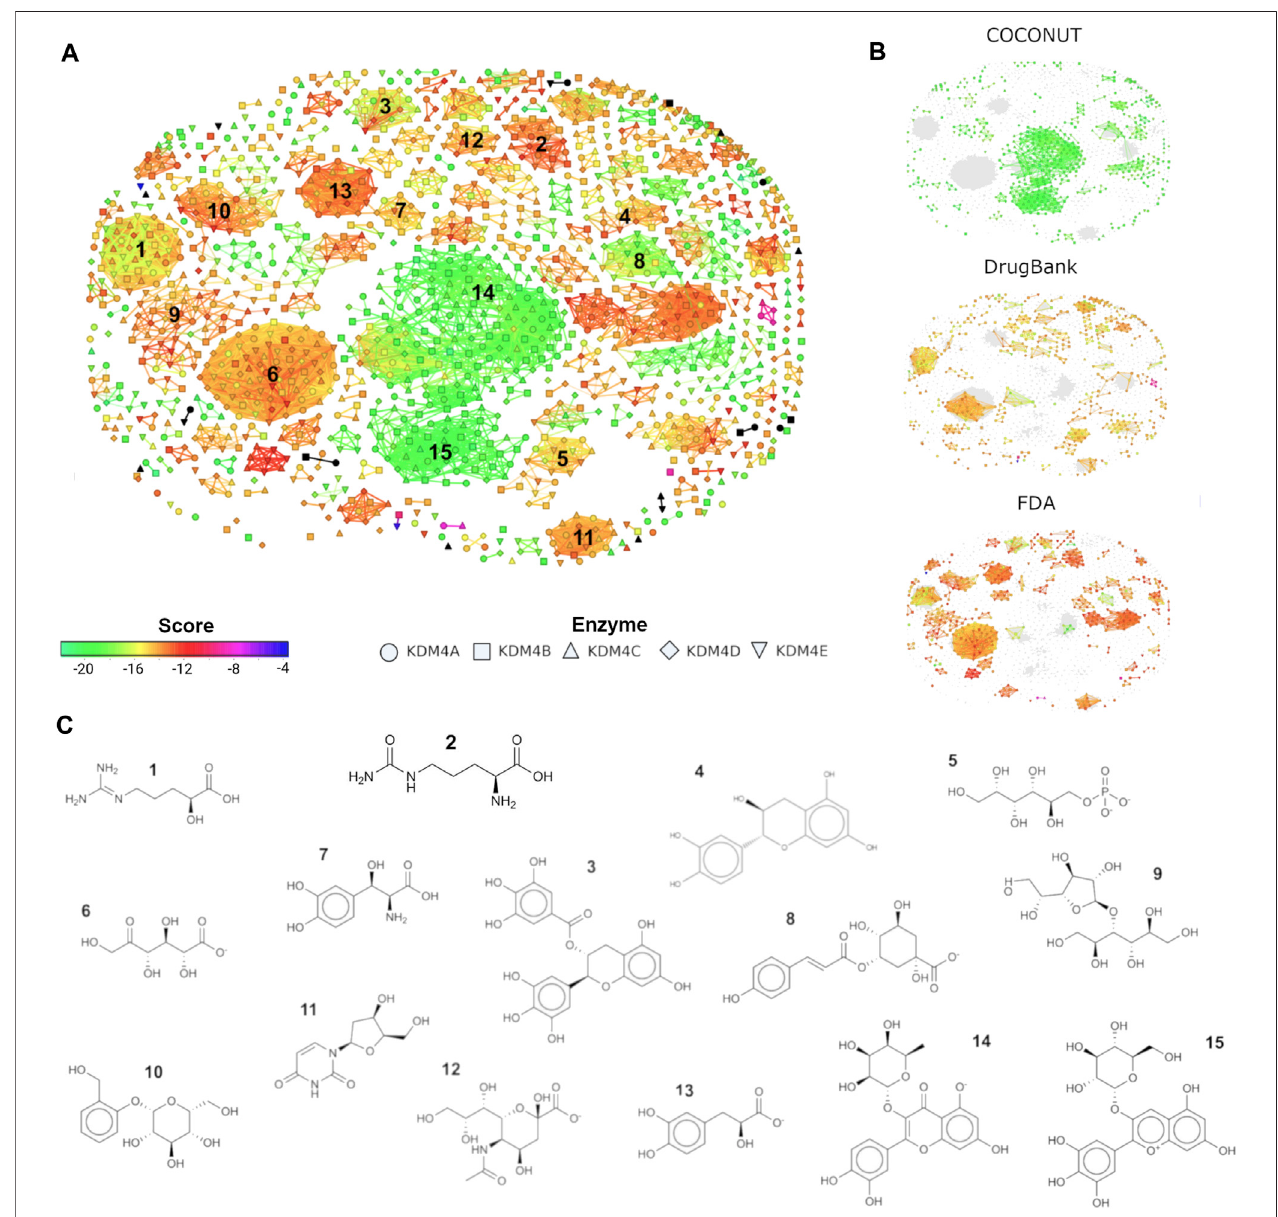
FIGURE 4 | Similarity fl exophores map for COCONUT, DrugBank, and FDA top hits. (A) Similarity fl exophores map. Each node represents a compound, the node color depicts its FRED/Chemgauss4 score. The node shape indicates which KDM4 the ligand binds. The network edges indicate a relationship of at least 95% of fl exophore similarity between compound pairs (neighbors). Black dots represent the compounds from Baby et al., 2021. (B) Node distribution for the compounds belongingtoeachofthedatabasesevaluated(COCONUT,DrugBank,andFDA). (C) 2Dstructureforarepresentativecompoundfromeachofthechosenclusters. Clusters were selected based on their size, and edge